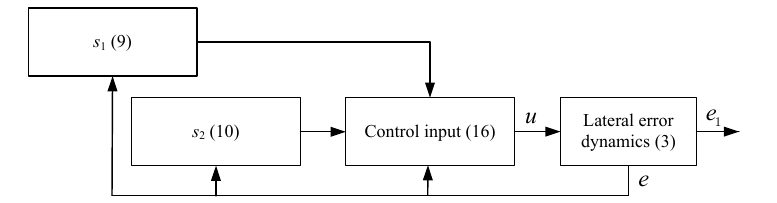
Figure 5. Block diagram of the proposed method.